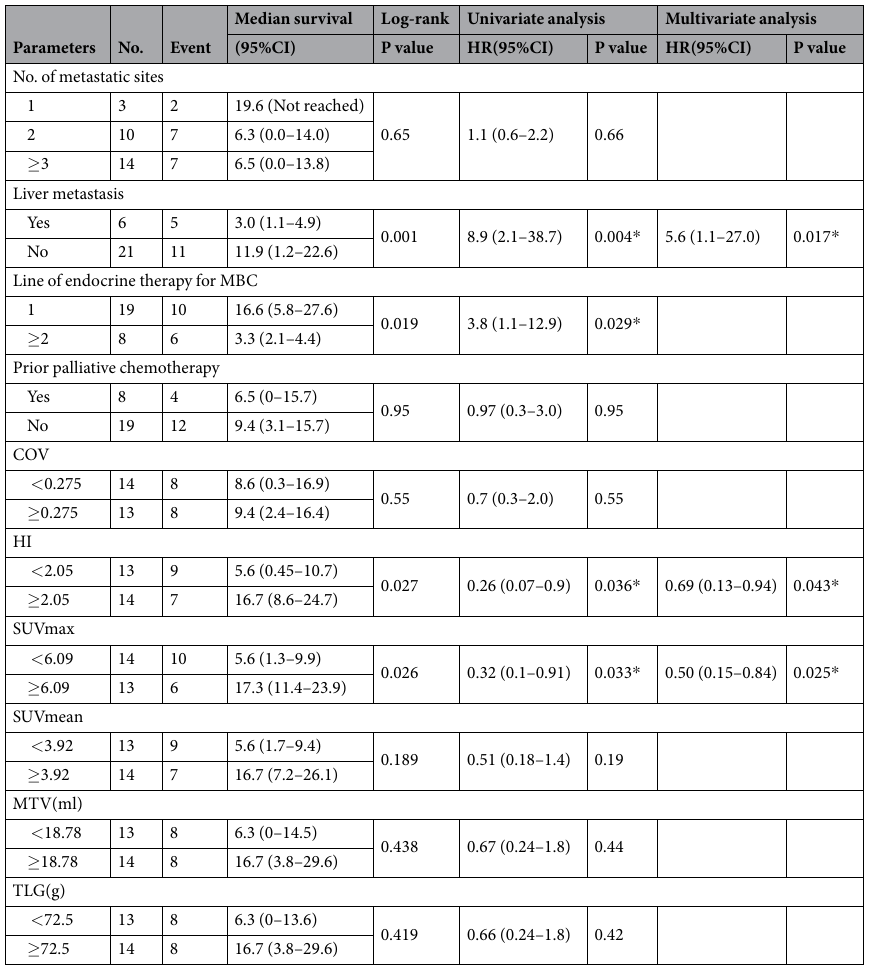
Table 2. Summary of progression-free survival analysis (bone only metastasis patients excluded). Abbreviations: CI, confidence interval; PFS, progression-free survival. COV, coefficient of variation. HI, heterogeneity index. SUVmax, maximum standard uptake value. SUVmean, mean SUV. MTV, metabolic volume measurements. TLG, total lesion glycolysis. * P <